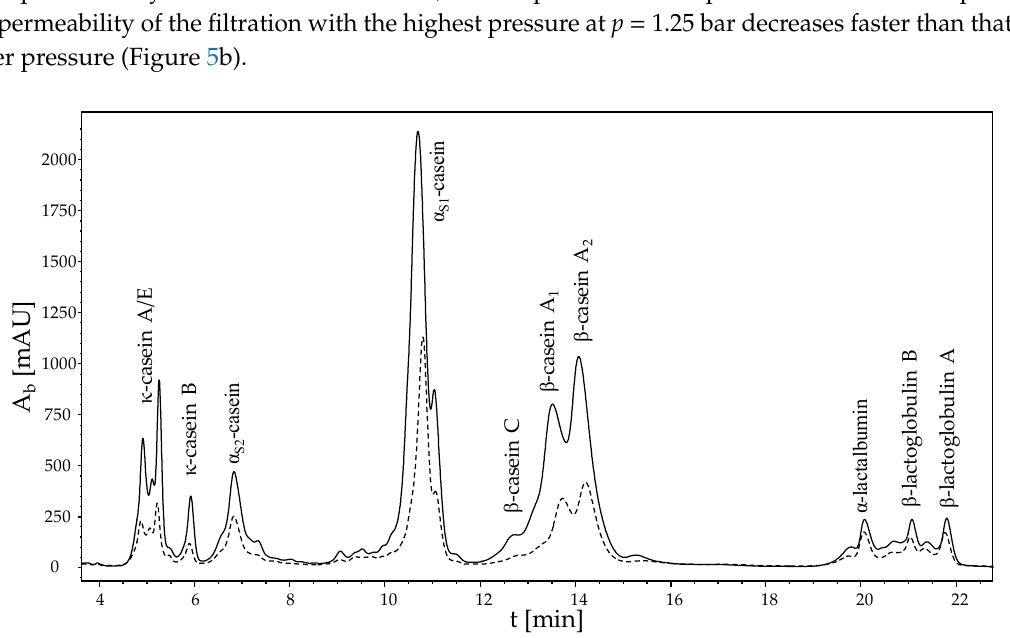
Figure 4. RP-HPLC chromatogram of the deposit (solid line) and the retentate skim milk (dashed line) of caseins and whey proteins in a guanidine buffer at z = 29 cm after approximately 3 h of dead-end filtration at p = 1.25 bar and ϑ = 22 °C. An enrichment of the different caseins in the filtration deposit is evident.